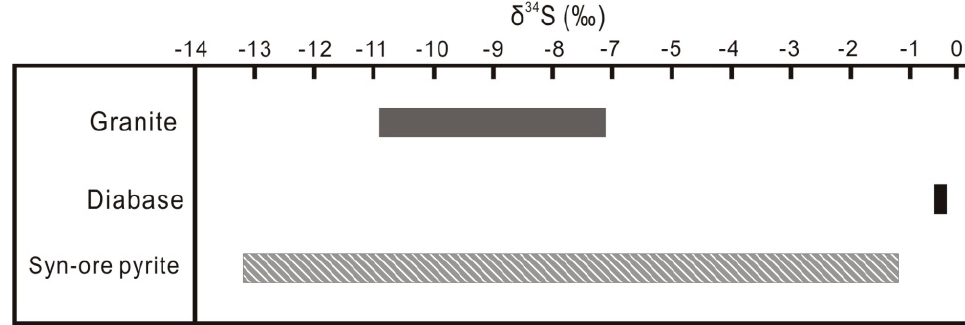
Figure 8. The δ 34 S ranges of pyrites from granites and diabase, and from syn-mineralization pyrite in the Mianhuakeng U deposit and its peripheral region. The sulfur isotope data of pyrites from granite and diabase were cited from Hu and Jin [48] and Zhan [32], respectively.